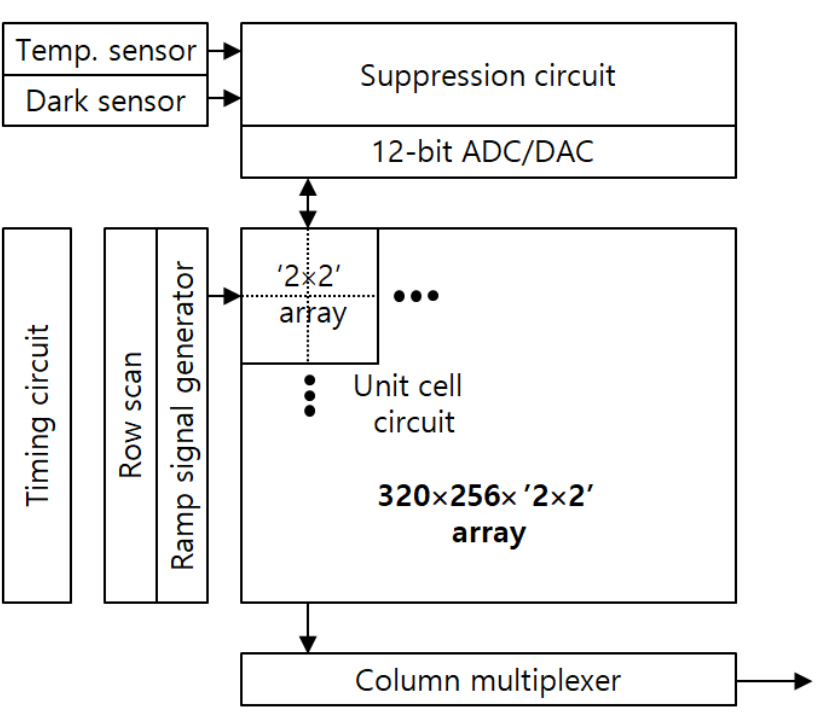
Figure 4. One-bit counter used in the unit cell circuit of Figure 2: ( a ) schematic diagram; ( b ) timing diagram.